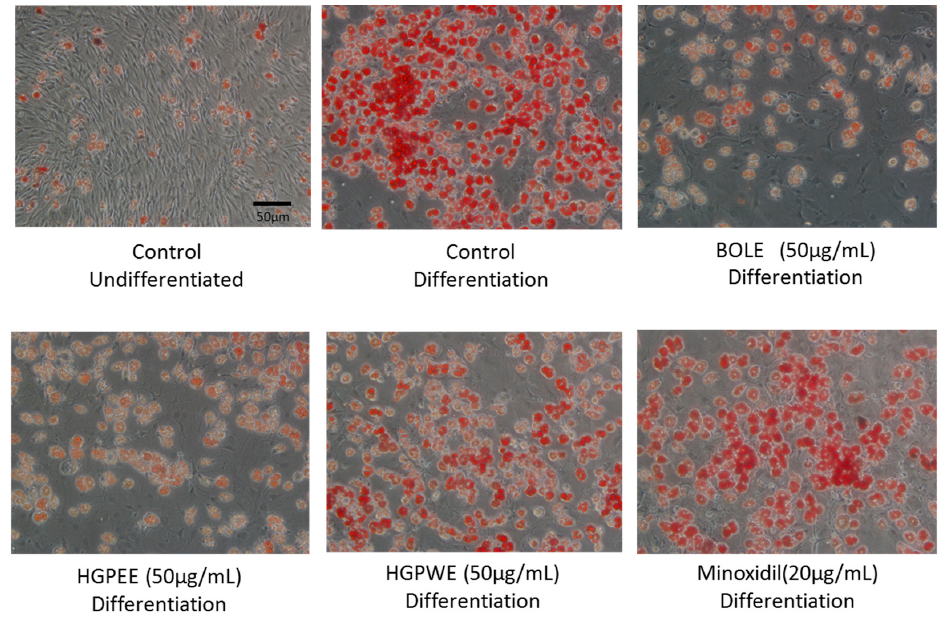
Figure 2. The shape of microscopic features of sebocytes dyed in oil red O.